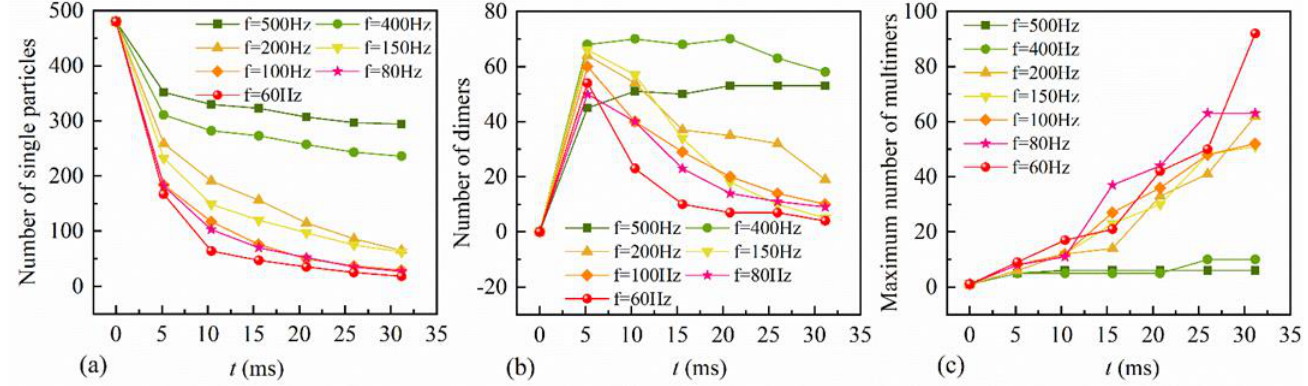
Figure 8. Evolution of ( a ) the number of single particles, ( b ) the number of dimers, and ( c ) the maximum number of multimers in the simulation under sound waves of SPL = 100 dB.